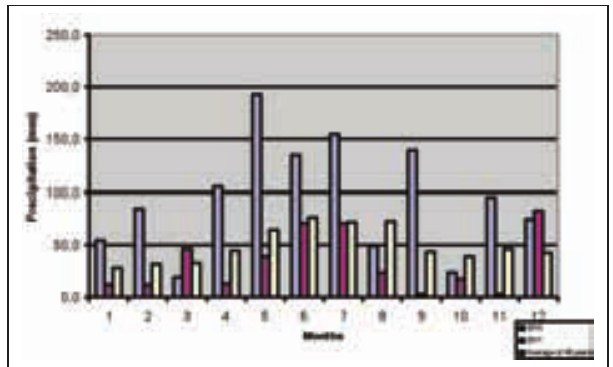
Figure 2: Scale used in the evaluation of the berry skin